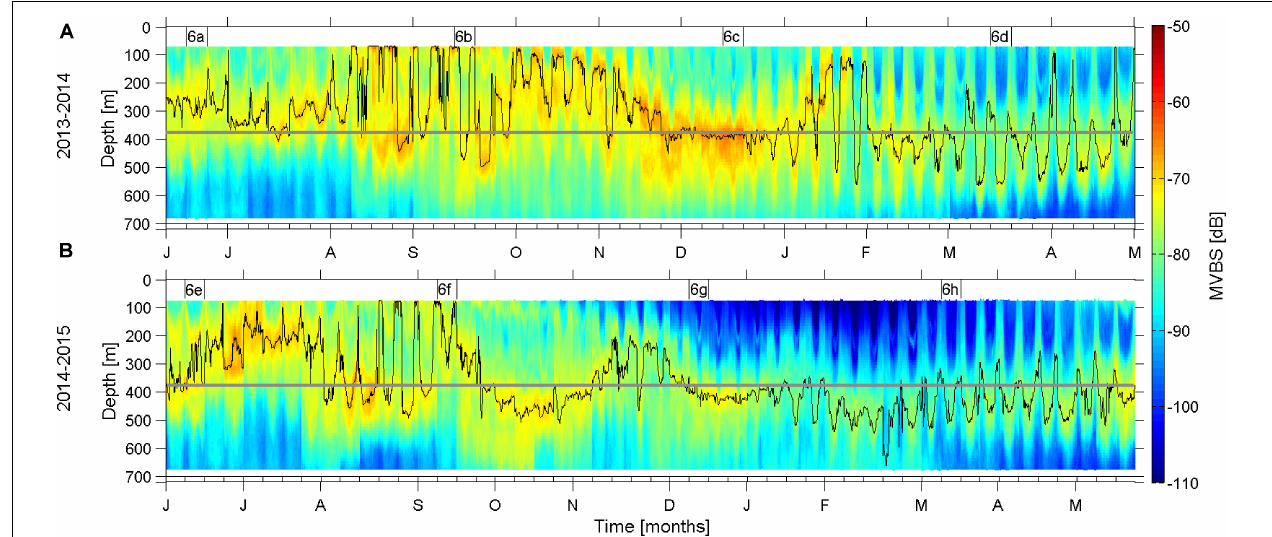
FIGURE 2 | Annual time series of weekly averaged 24 h cycles of mean volume backscatter strength from June 2013 to May 2014 (A) and from June 2014 to May 2015 (B) , i.e., each weekly slot shows the average 24 h cycle of that week. Overlaid is the weighted mean depths (WMD) (black lines). The Figures 6A–H at the top of the panels refer to the weeks, illustrated in the corresponding Figure 6 panels. The average depth of the interface ( ∼ 380 m, see Figure 1B ) is illustrated with a horizontal gray line.